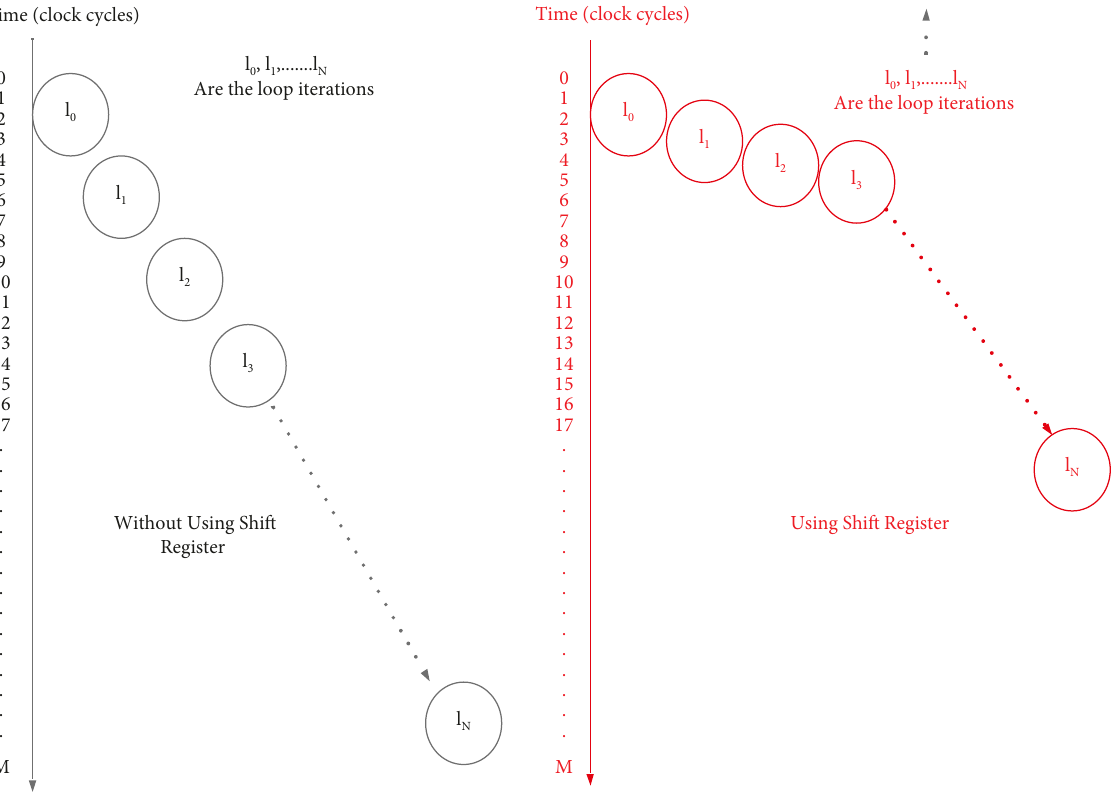
Figure 4: Enhancing the initiation interval (II) by using the shift register